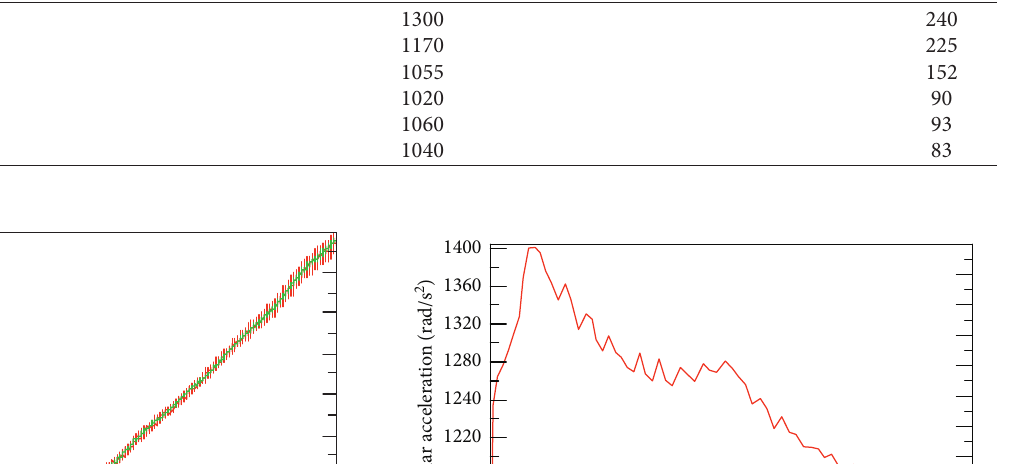
Table 8: The 2 nd order angular acceleration amplitudes under the driving condition for the powertrain matching the DMF with the bifilar CPVA. Engine speed (r/min)